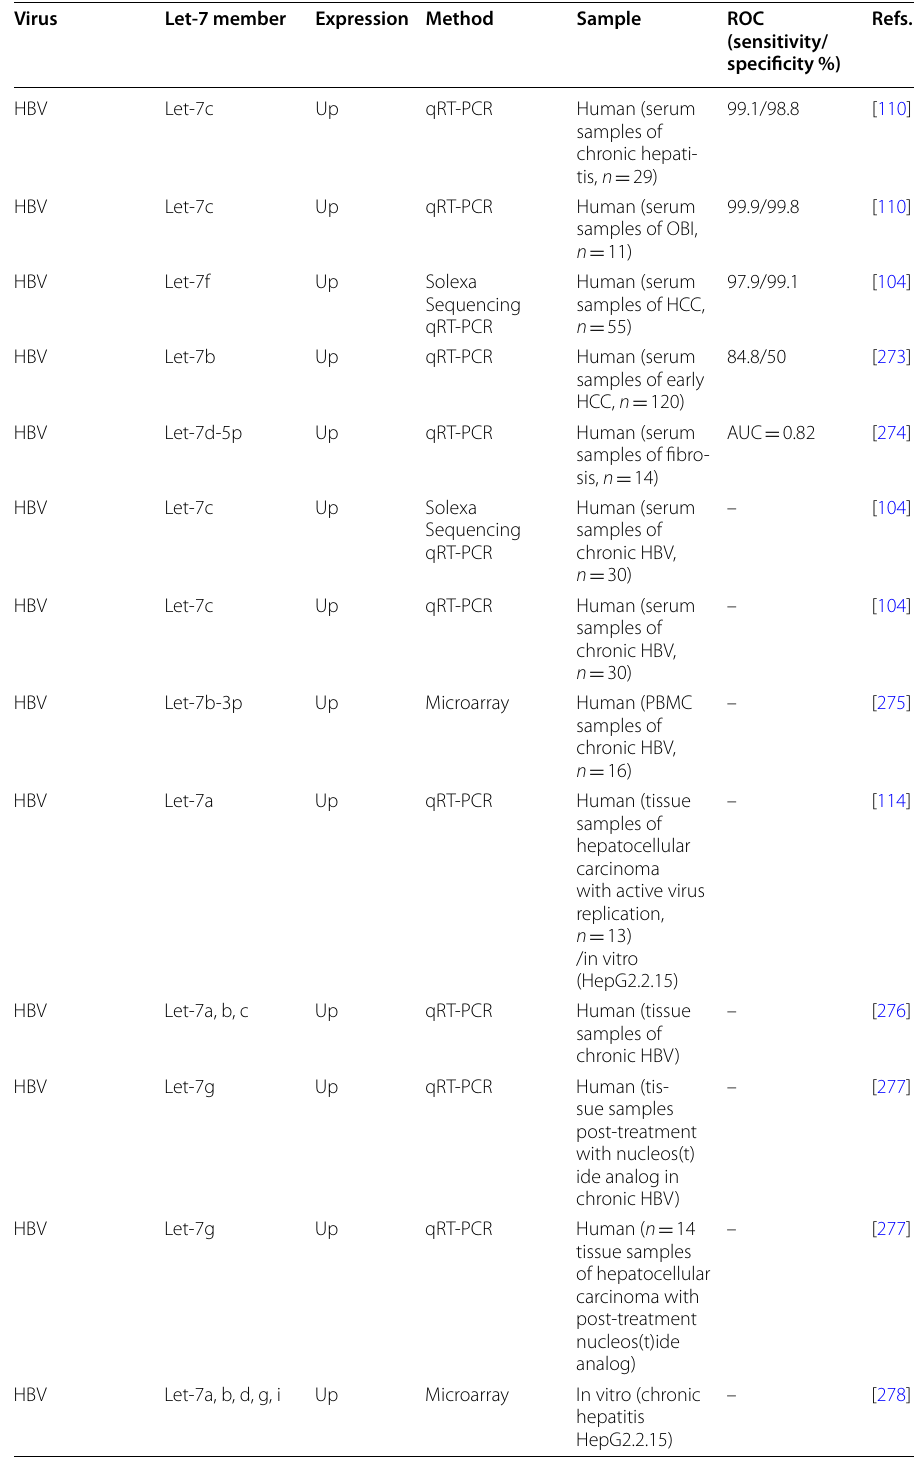
Table 1 Role of let‑7 family members as biomarkers in viral infections